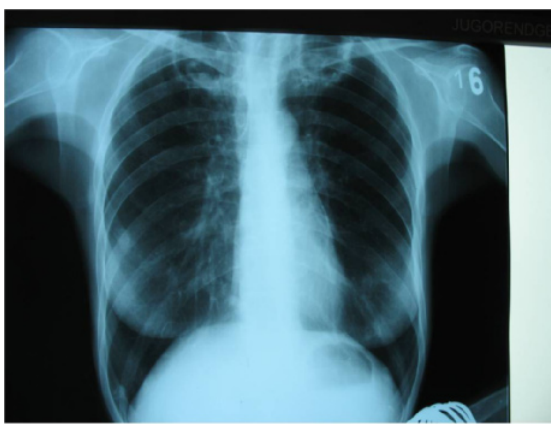
Figure 1. Chest X-ray showing round shadows with illumination in both lung apexes, more prominent in the right one